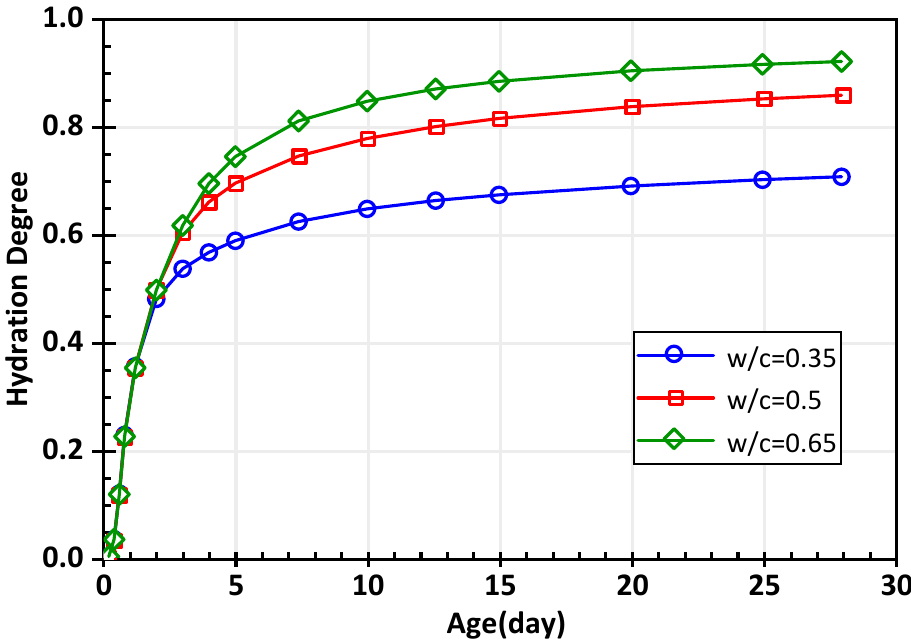
Figure 2. The predicted curve of the hydration degree increasing with age from the DuCOM model.